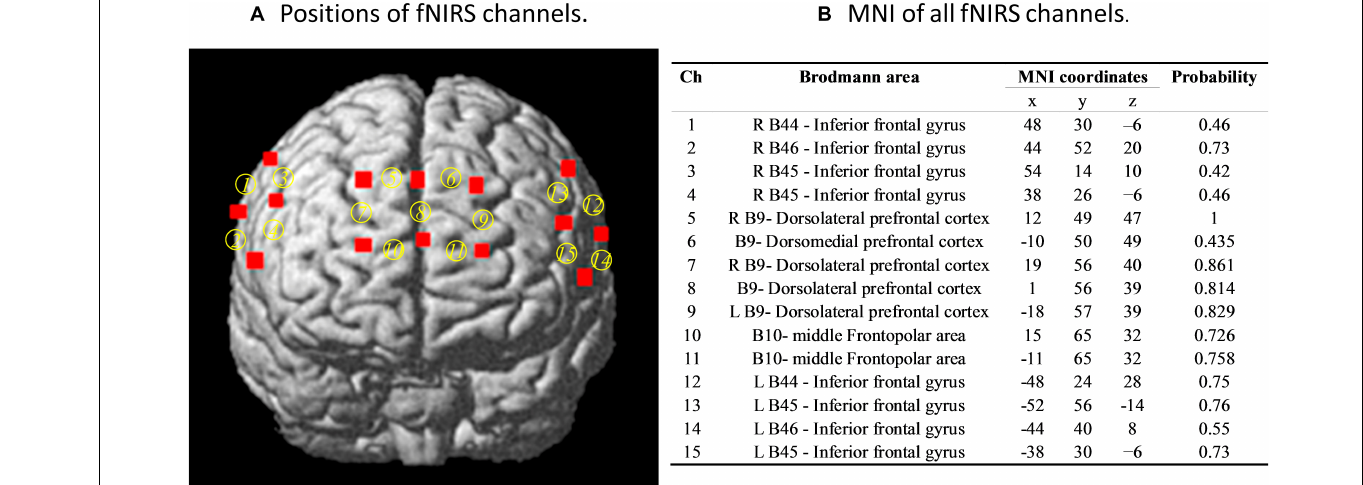
FIGURE 2 | (A) Positions of functional near-infrared spectroscopy (fNIRS) channels and (B) the Montreal Neurological Institute (MNI) brain space of fNIRS channels. Six optodes (three emitters and three detectors) were attached to the forehead in a 2 × 3 lattice pattern, forming seven measurement channels, covering approximately the middle parts of the frontopolar area and the dorsal lateral prefrontal cortex. The remaining two optodes (two emitters and two detectors) were placed on the bilateral inferior frontal regions in two 2 × 2 lattice patterns forming, eight measurement channels. The probability here is that our measured MNI position covers the brain